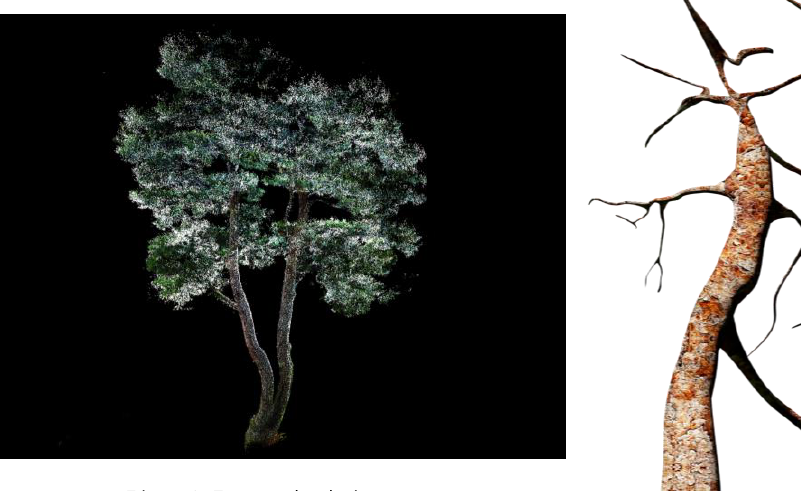
Figure 3. Extracted red pine tree